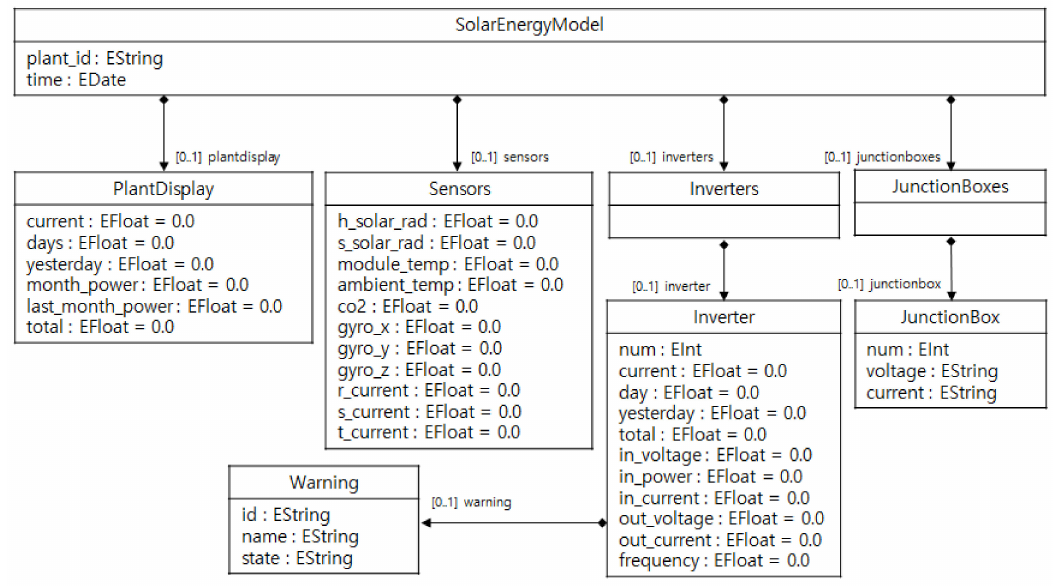
Figure 4. Integrated metamodel for heterogeneous data